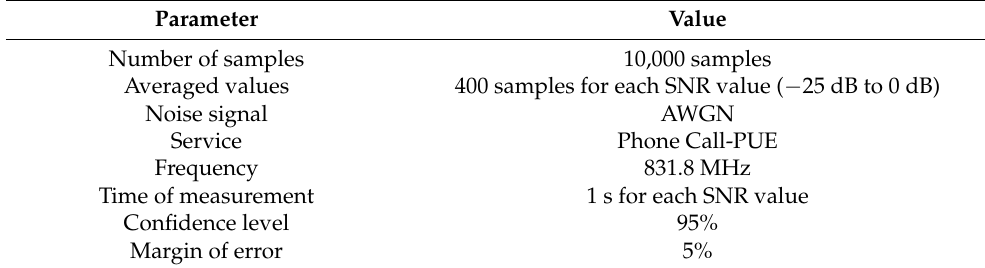
Table 1. Experimental parameters for the learning